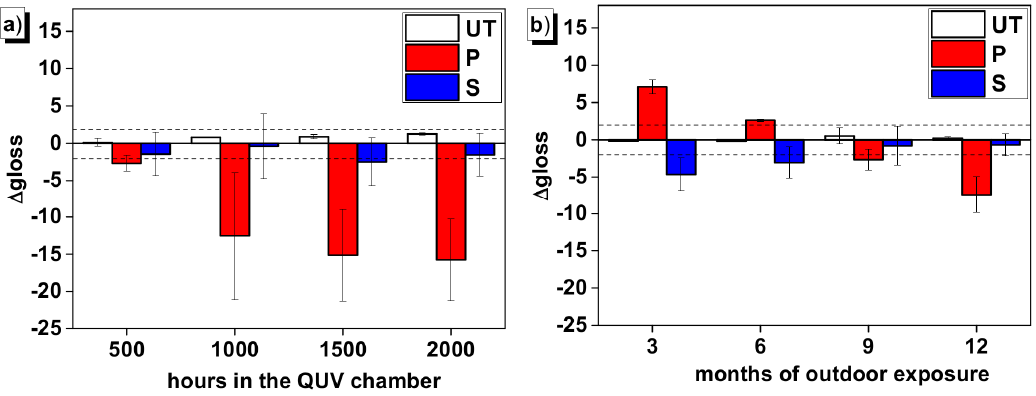
Figure 4. Variation of gloss on the surfaces of concrete: uncoated (UT) and coated with a permanent (P) and a sacrificial (S) anti ‐ graffiti treatment after accelerated ( a ) and natural ( b ) weathering.